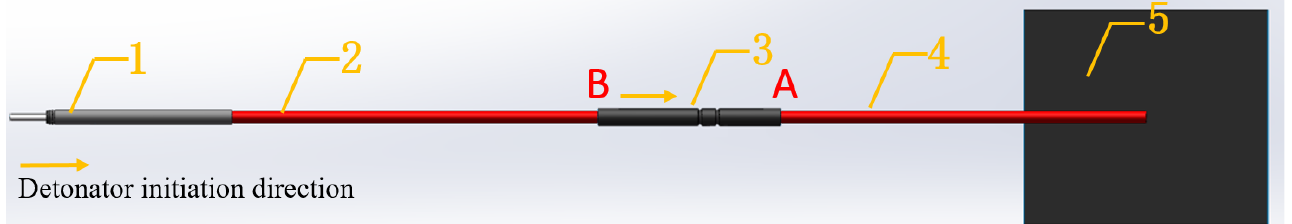
Figure 6. Structure diagram of the explosion-proof experiment, 1—detonator, 2—detonating cord of end B, 3—explosive diode, 4—detonating cord of end A, 5—the thickness of 0.2 mm